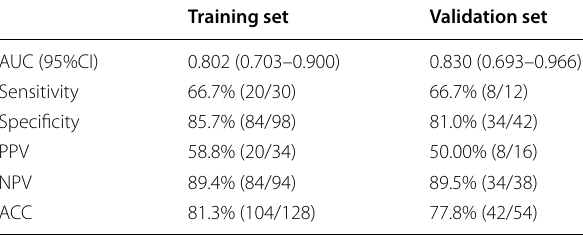
Table 4 Diagnostic performance of models for predicting histological differentiation of hepatocellular carcinoma